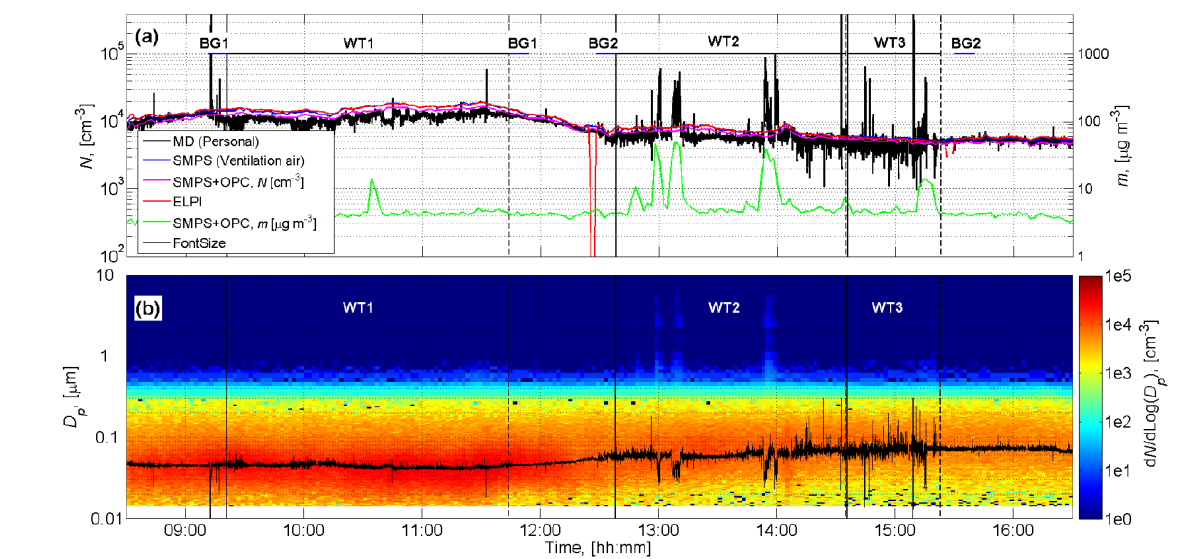
Figure 3. Concentration time series during the work day: ( a ) shows the particle and mass concentrations; ( b ) shows the particle size distributions measured with the SMPS + OPC and the average particle size defined by the DISCmini. The horizontal blue lines and the horizontal black lines in ( a ) show the start and end time for background concentrations (BG1 and BG2) and work tasks ( WT1 , WT2 , and WT3 ), respectively. The vertical solid and dashed thin black lines show the start and end times of the work